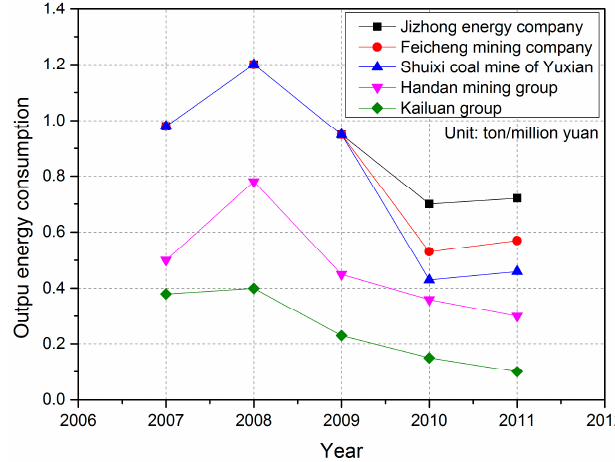
Figure 6. Output energy consumption of the coal mining enterprises in Yuxian.